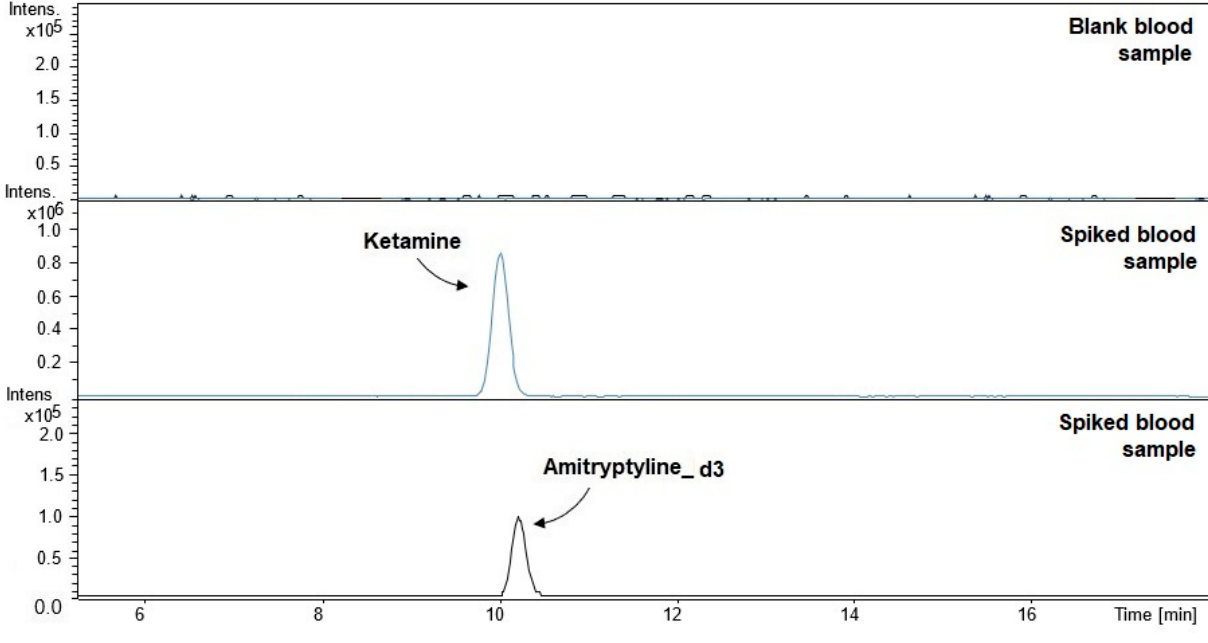
Figure 1. Electropherograms of blank and spiked blood samples (ketamine at a concentration of 150 ng/mL: t m = 10.0 ± 0.6; amitriptyline-d3 at a concentration of 150 ng/mL: t m = 10.1 ± 0.5).